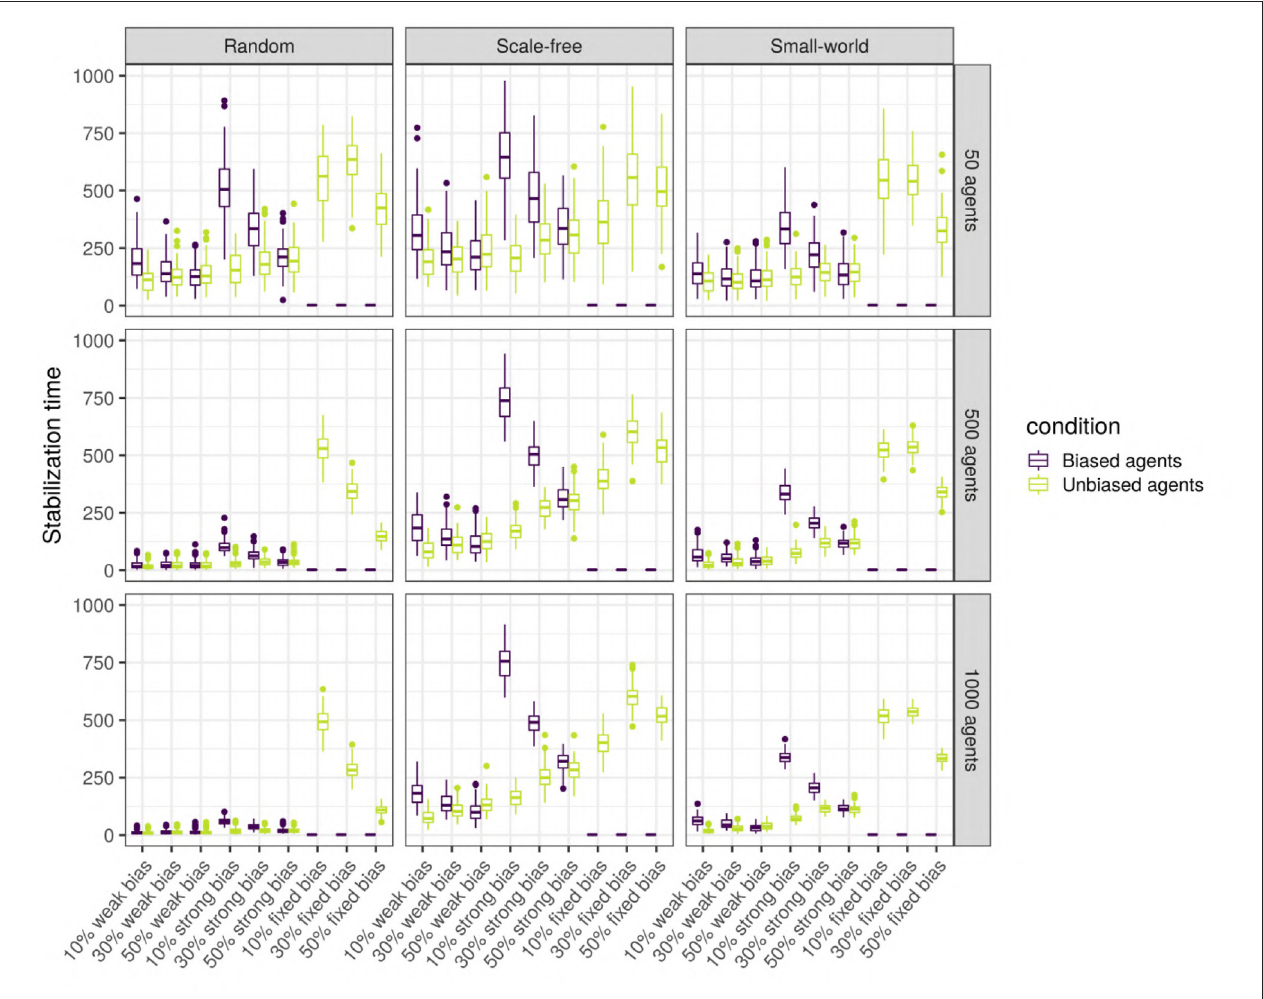
FIGURE 13 | Stabilization time for the biased and the unbiased agents (color), in different types of networks (columns) with two different sizes (rows), for various bias frequencies and strength (horizontal axis). The agents are SAM, there are no biased influencers, and there is an initial language.